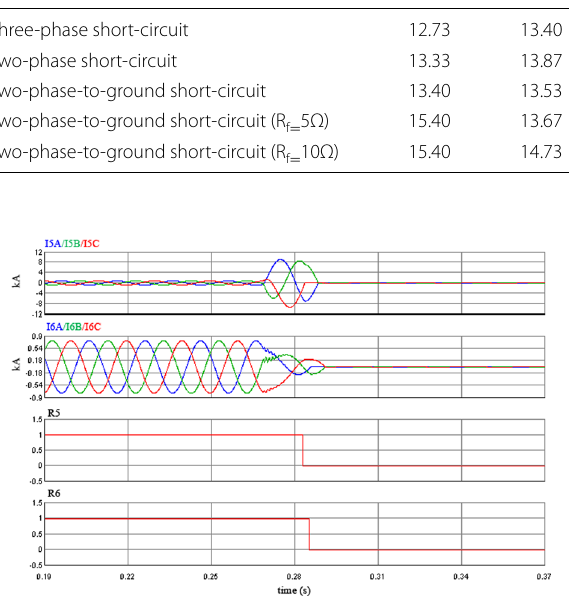
Fig. 14 Fault record for an internal three-phase fault of section N 3 N 4